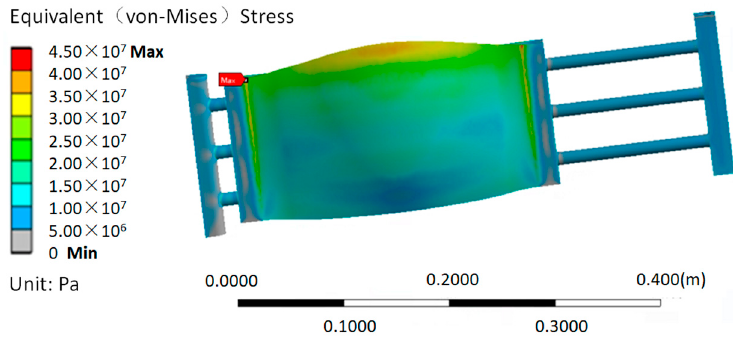
Figure 12. Structure equivalent (Von Mises) stress (at the 100th second).